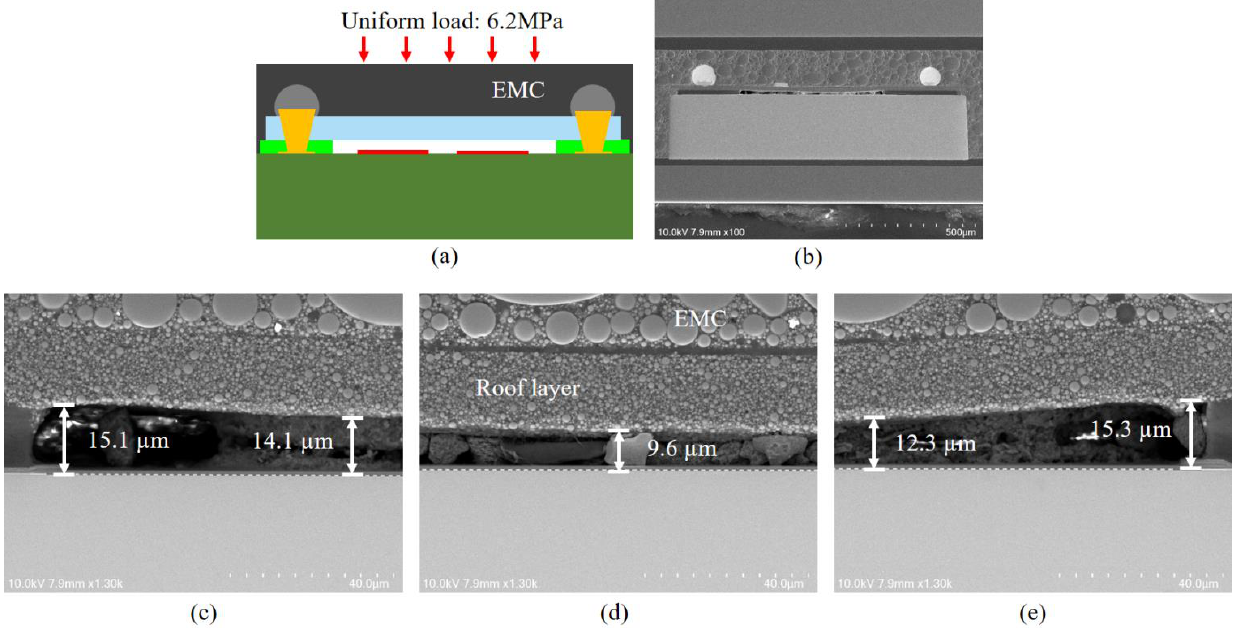
Figure 13. Experimental results of collapse test by applying 6.2 MPa pressure. ( a ) Schematic of molding pressure test; ( b ) indicates the SEM image of the SAW device molding pressure test; ( c – e ) indicate the degree of collapse of the cavity at the left, middle and right positions,